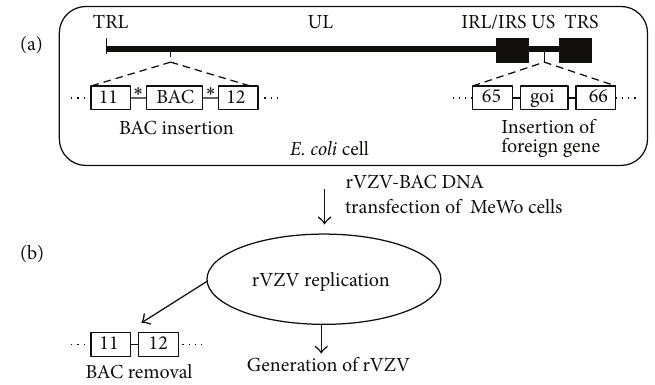
Figure 2: VZV-BAC approach to generate rVZV. BAC sequences are inserted into the VZV genome within the intergenic region between ORFs 11 and 12 and maintained within E. coli . A foreign gene of interest (goi) with promoter is inserted between ORFs 65 and 66. rVZV-BAC DNA is transfected into MeWo cells to generate infectious rVZV. BAC sequences flanked by lox P sites ( ∗ ) may be removed from the VZV genome by Cre